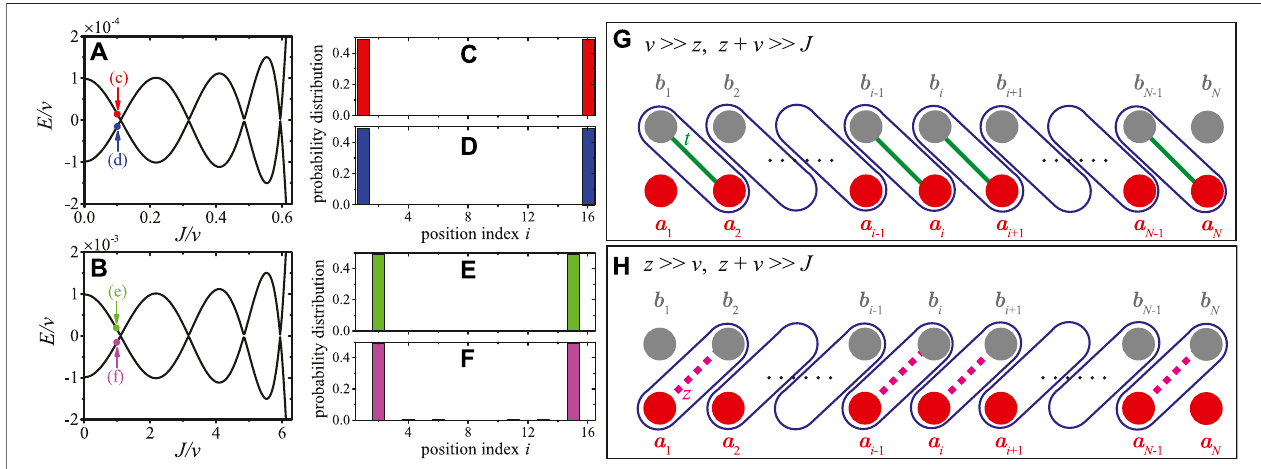
FIGURE6| (Coloronline) (A, b) arethelocalenlargeddrawingsof( Figures5A,D ). (C – F) showtheprobabilitydistributions oftheeigenfunctionscorresponding to thepointsshownin (A,B) . (G) Edgestatesappearat a 1 and b N correspondingto (C,D) for v ≫ z and J ≪ v + z . (H) Edgestatesappearat b 1 and a N correspondingto (E, F) for z ≫ v and J ≪ v + z